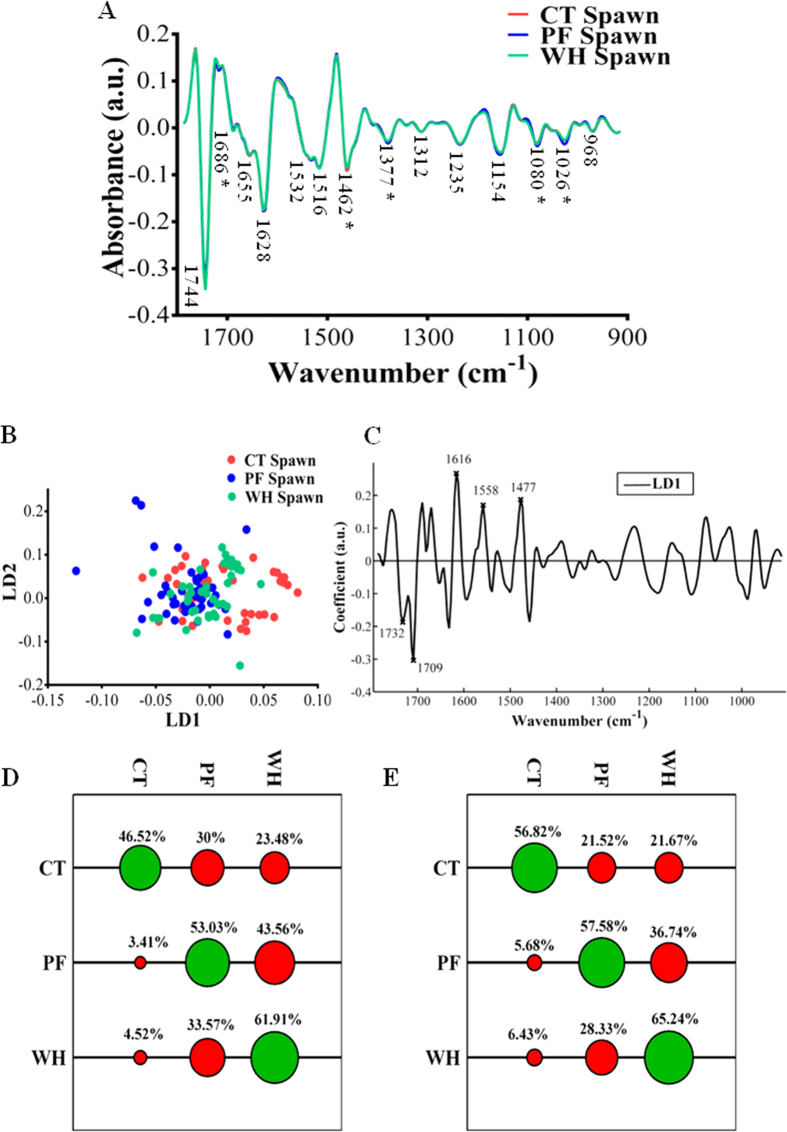
(A) Second derivative mean spectra of Rana temporaria spawn collected over a three year period (2012–2014) from CT (Crake Trees): a rural agricultural pond with minimal pesticide input; PF (Pennington Flash): an urban pond impacted by wastewater and landfill run-off and WH (Whinton Hill): an agricultural pond known to be impacted by pesticides. Spectra were cut at the biochemical fingerprint region (1800–900 cm−1), processed with Savitzky-Golay second-order differentiation and vector-normalised. Asterisks denote significant differences (P < 0.05) at absorbance peaks following one-way ANOVA. (B) Two-dimensional scores plot generated following cross-validated PCA-LDA analysis of spectra. (C) Corresponding loadings generated from PCA-LDA analysis; the five largest loadings values are highlighted. (D) Spawn classified by PCA-LDC. (E) Spawn classified by SVM. Green circles show % correct classification rate, red circles show % incorrect classification rate.